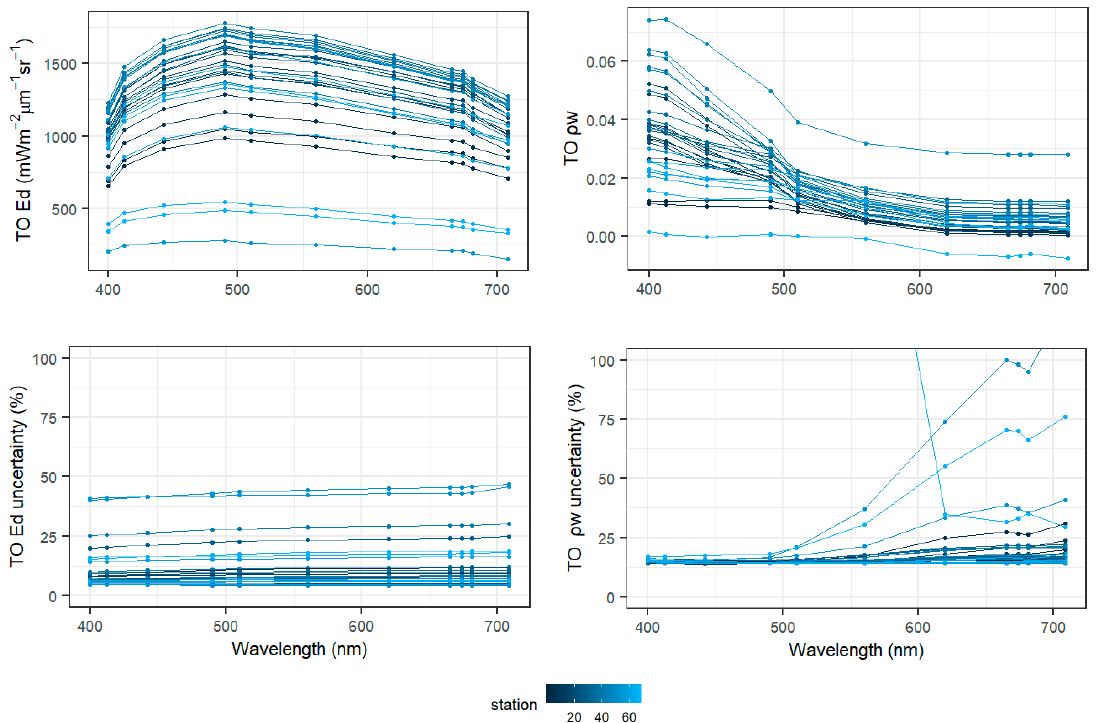
Figure 4. Upper panel: E d (left) and ρ w (right) spectra, re-calculated for OLCI (Ocean and Land Color Instrument) channels. Lower panel: expanded uncertainties of downwelling solar irradiance ( E d ) and water-leaving reflectance ( ρ w ). The color denotes the station ID, as listed in Table 1.